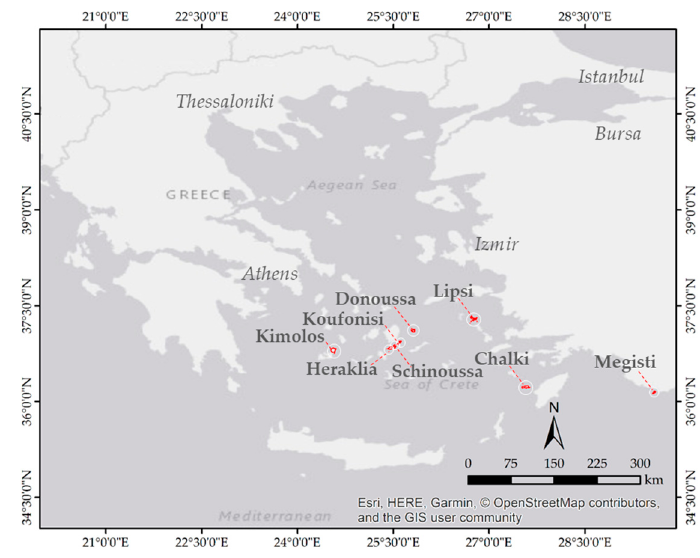
Figure 1. Map of the study area. White circles indicate the location of each island.